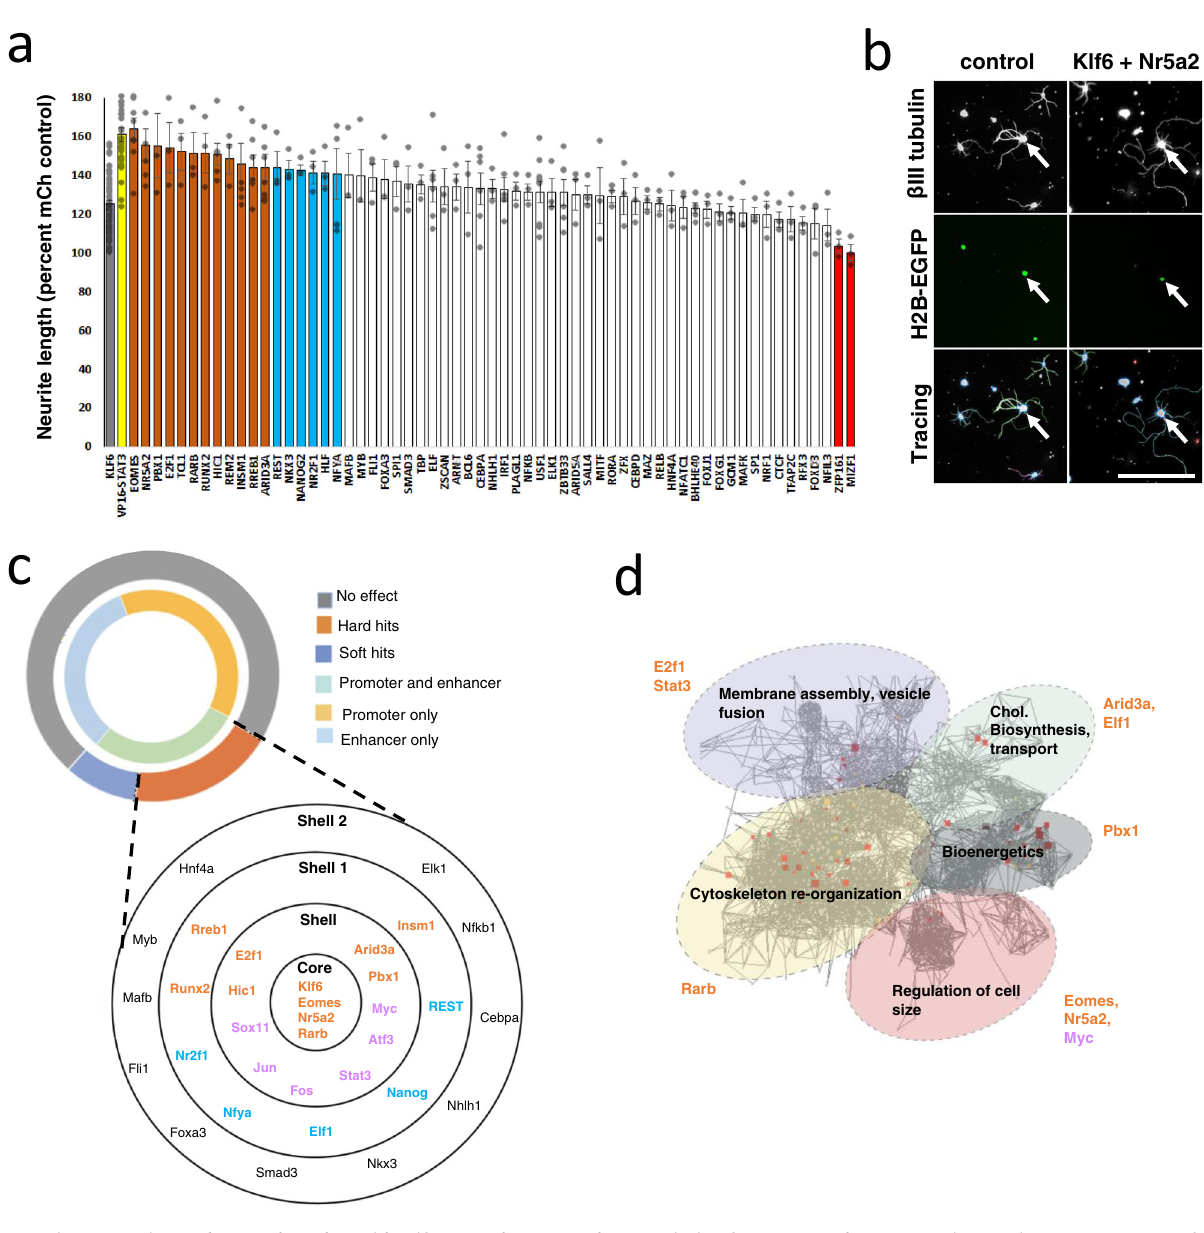
Fig. 2 In vitro screening and network analyses identify a novel pro-growth transcription factor network. a Postnatal cortical neurons were transfected with control plasmid, Klf6 with control, Klf6 with VP16-Stat3, or Klf6 combined with 62 candidate TFs. After 2 days in culture, automated image analysis (Cellomics) quanti fi ed neurite lengths normalized to the average of on-plate controls. The solid black line indicates the average control length. Combined expression of Klf6 and Vp16-Stat3 showed expected increase in neurite length above Klf6 alone, con fi rming assay sensitivity (yellow bar, p -value < 0.0001, ANOVA with post hoc Fisher ’ s LSD). Twelve candidate TFs signi fi cantly enhanced neurite outgrowth when combined with Klf6 (orange bars, p -value < 0.05, ANOVA with post hoc Fisher ’ s LSD) and fi ve more enhanced growth in two of three replicates but missed the cutoff for statistical signi fi cance (blue bars). n > 150 cells in each of three replicate experiments with similar results; exact cell numbers and p -values are available in Supplementary Data 2. b Representative images showing transfected neurons (white arrows, H2B-EGFP) and neurite tracing. c Network analysis was performed on transcripts upregulated by Klf6 overexpression in culture neurons, followed by motif analysis of gene promoters within each module. Of the ten TF motifs with the highest enrichment, seven were hit TFs from the screening experiment (orange), including Rarb, Eomes, and Nr5a2. d Hit TFs were used to build networks. All hit TFs derived from candidates with predicted Klf6 co-occupancy in both promoters and enhancers. Rarb, Eomes, and Nr5a2 were located in the network core, where Klf6 itself also appeared during network construction. Several soft hit TFs (blue) and established pro-growth TFs (pink) spontaneously populated outer shells. Scale bar is 100 µ m, error bars indicate SEM. Source data are provided as a Source Data fi